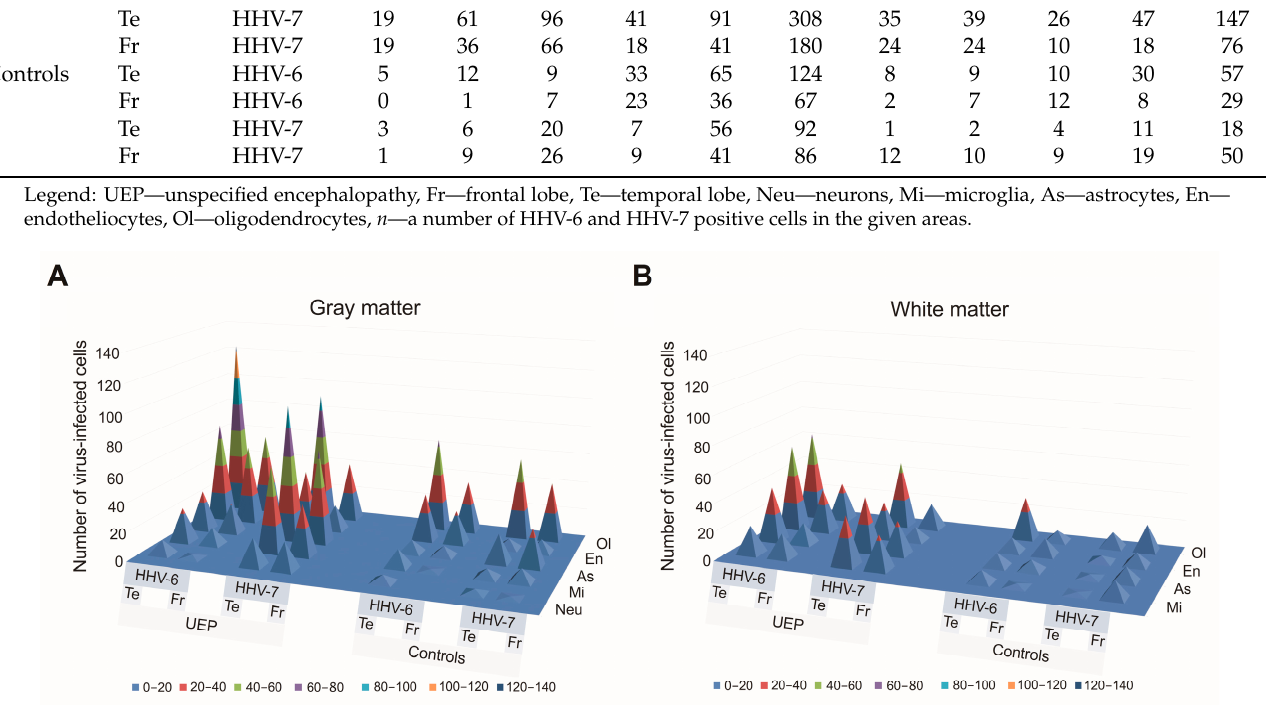
Figure 3. Pyramidal 3D surface plots representing the data of immunohistochemical (IHC) analysis in the PCR+ samples: numbers of herpesvirus-6, -7 (HHV-6, -7) positive Neu (neurons), As (astrocytes), Ol (oligodendrocytes), Mi (microglia), En (endotheliocytes) in the gray ( A ) and white ( B ) matter of the unspecified encephalopathy (UEP) group and controls, frontal lobe (FR), temporal lobe (Te). The blue plane represents a zero level (no virus-infected cells in the visual